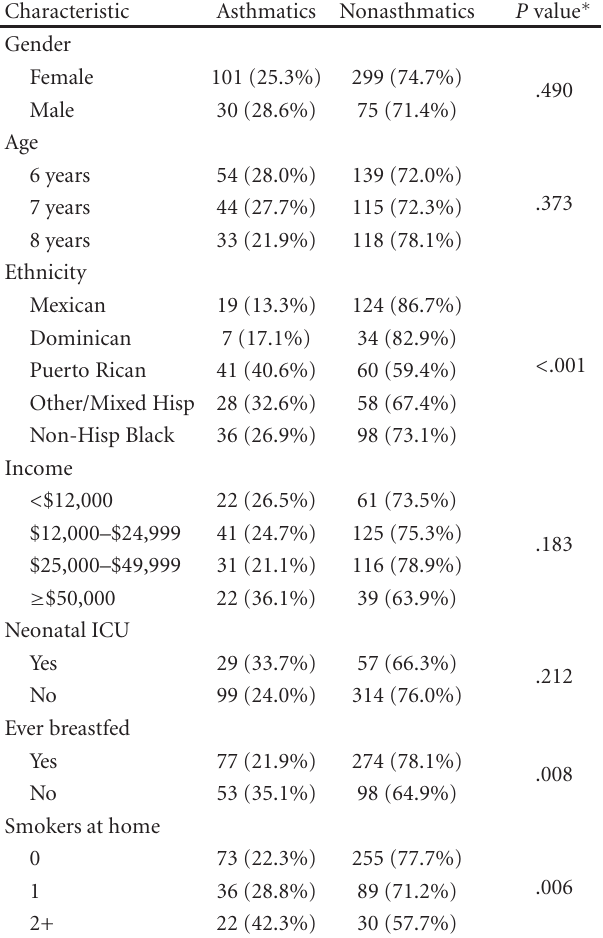
Table 2: Asthma rates for subgroups of New York City children